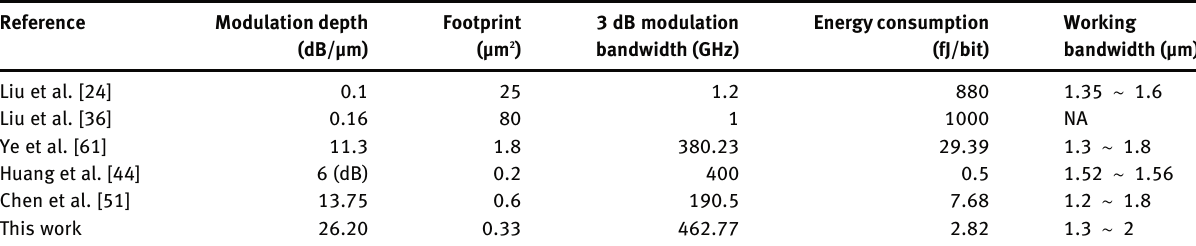
Table  : Comparison of recently reported